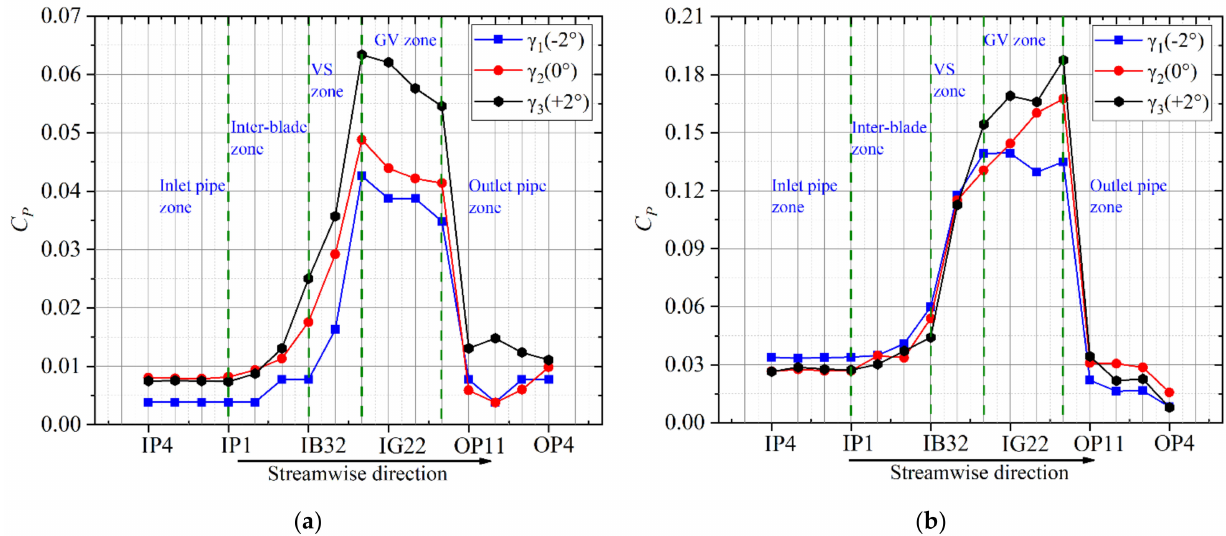
Figure 23. Pressure pulsation distribution in the streamwise direction for different γ values: ( a ) rated operating condition, ( b ) deep part-load operating